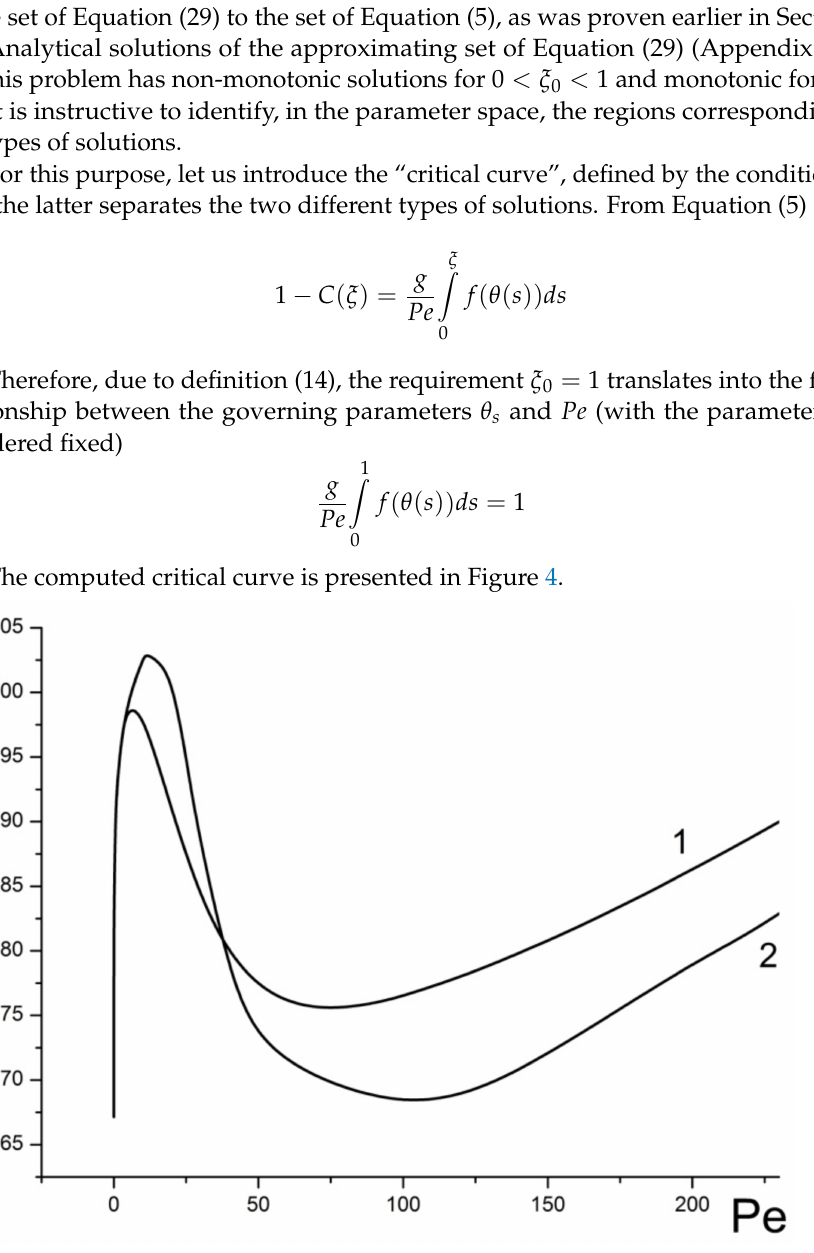
Figure 4. Critical curve θ s = θ s ( Pe ) . 1—approximate model (29); 2—original model (5); A = 2.75 × 10 − 18 ; Ar = 0.012; h s = 7.14 × 10 2 ; g = 1.0 × 10 − 20 ; µ =